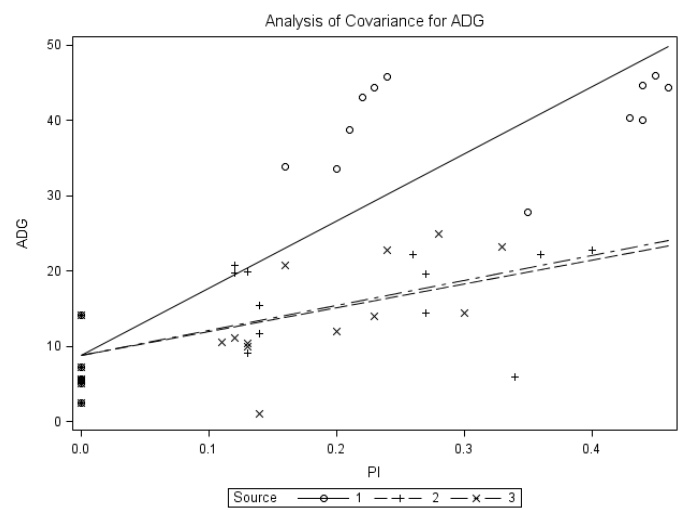
Figure 2. Common-intercept, multiple-linear regression of average daily gain (ADG; g) on supplemental P intake of chicks fed diets supplemented with P from monosodium phosphate (MSP; Source 1), brown-seeded pea (BP; Source 2), and Yellow-seeded pea (YP; Source 3). The circular marker represents MSP, the plus marker represents BP, and the multiplication marker represents YB. The common-intercept, multiple-linear regression equation (mean±standard error) was Y = 8.83±1.44+89.02±7.11MSP+31.72±9.73BP+ 33.22±11.40YP, R2 = 0.76, p<0.0001; the relative bioavailabilities estimated by slope-ratio were 35.6% and 37.3% for BP and YP,